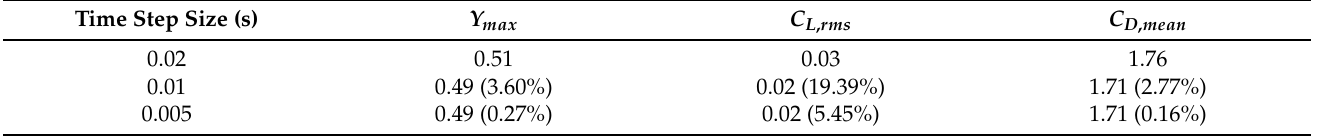
Table 4. Dependence of numerical results on the time step size. All the numerical simulations were conducted at fixed values of Re = 150, m ∗ = 2.5465, ζ = 0, and U r =